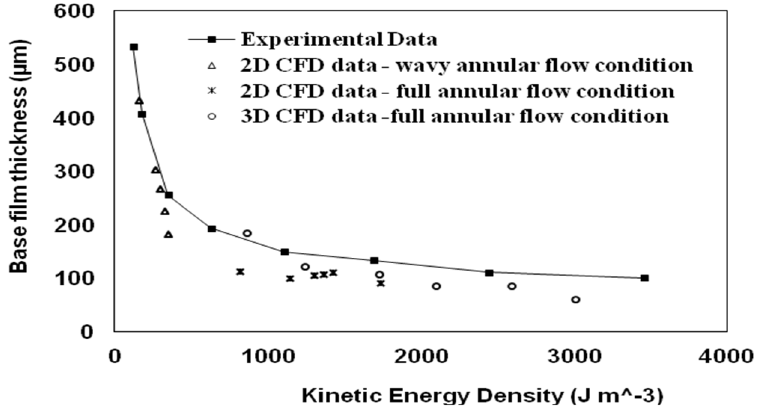
Figure 16. CFD predicted air flow kinetic energy density variations with the water base film thick- ness, in comparison with experimental data